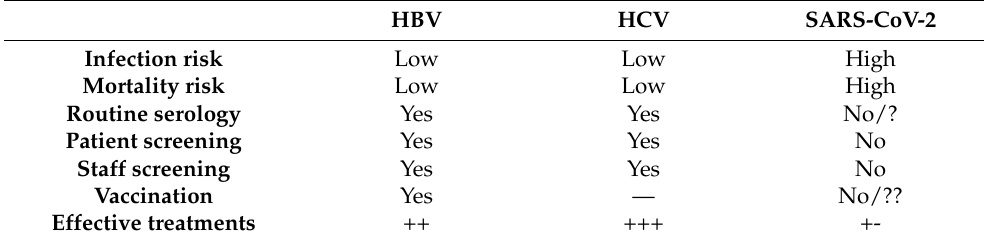
Table 1. Infection prevention and